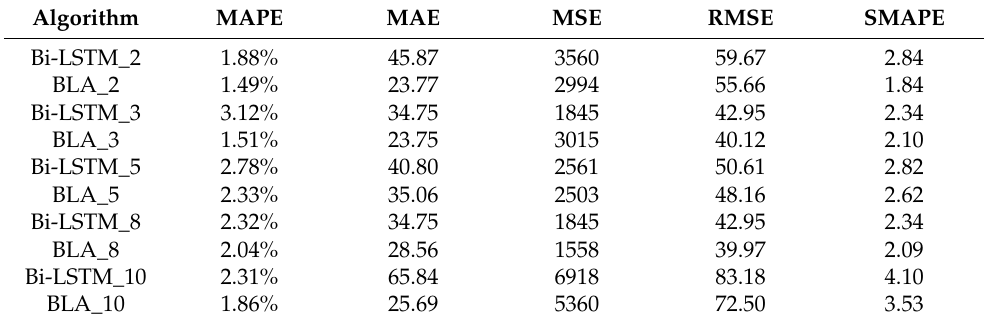
Table 4. The load forecasting experimental results with different cluster center